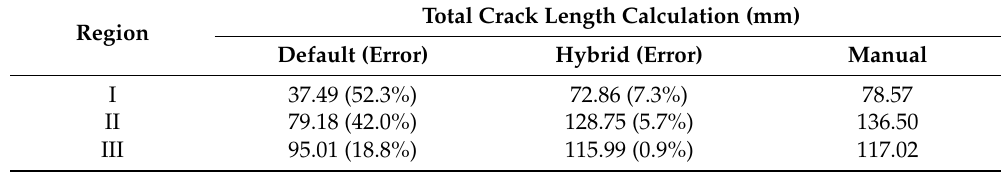
Table 4. Comparison of obtained crack widths.